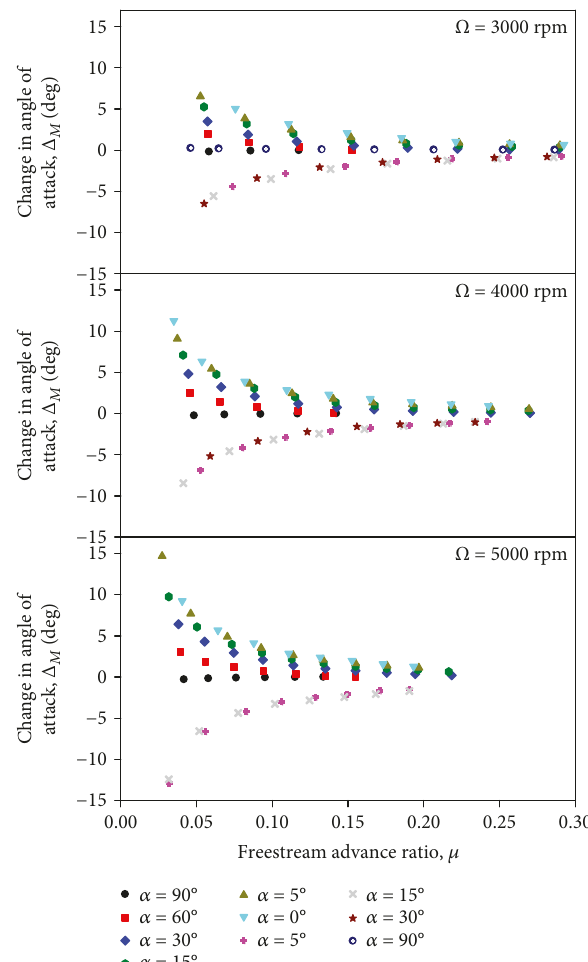
Figure 12: Change in angle of attack due to wall interference for T- motor 18x6.1 at various uncorrected angles of attack under di ff erent rotational